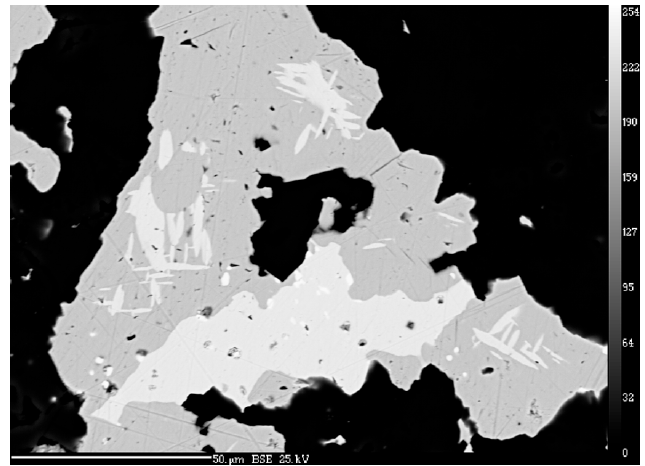
Figure 35. Umangite (dark grey) aggregates partly replace earlier eucairite (light grey). BSE photograph. P ř íbram, a dump of shaft 16. Photo by J. Sejkora and P. Škácha. Minerals 2017 , 7 , 91